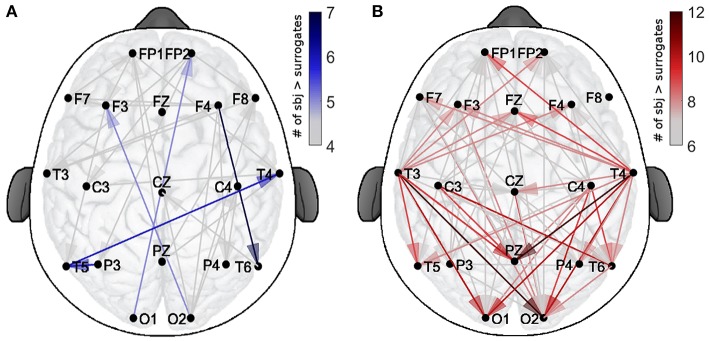
Spatial distribution of the validated coupling strengths. The color codes indicates the number of subjects with a higher direct-coupling strength than the corresponding surrogate threshold for (A) EO and (B) EC. Note the different scalings of the two color-bars, used for clarity.